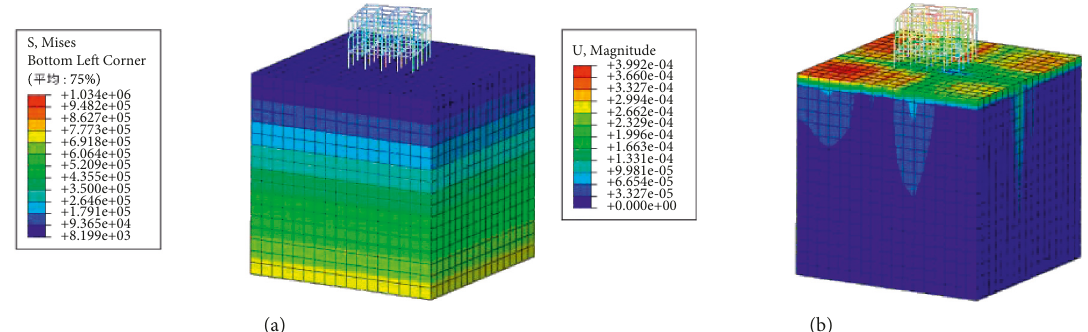
Figure 3: Ground stress balance calculation results of the stratum-structural model using ODB import method. (a) Stress nephogram. (b) Displacement nephogram.